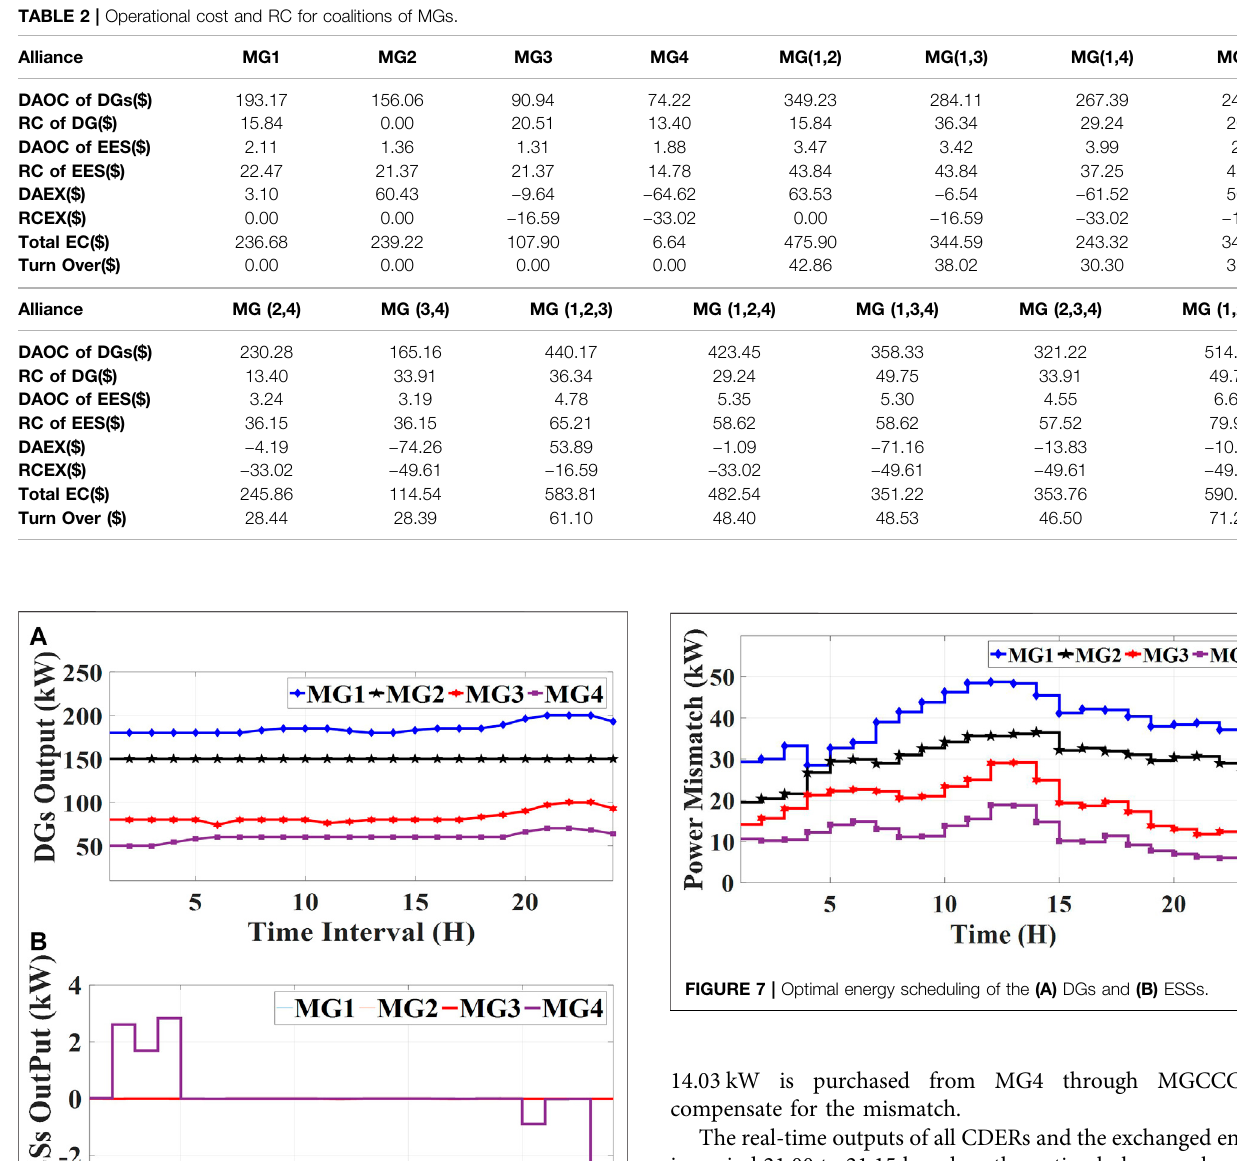
14.03 kW is purchased from MG4 through MGCCC to compensate for the mismatch. The real-time outputs of all CDERs and the exchanged energy in period 21:00 to 21:15 based on the optimal plan are shown in subsection Figure 9 . The output of the WTs in MG1 increases from 42.1 kW (planned value) to 50.52 kW (real-time value), the load increases from 302.70 kW to 332.97 kW, and the PV output decreases from 1.44 kW to 1.296 kW. Since the DG was scheduled to operate on a full load, it cannot participate in reducing the mismatch. Therefore MG1 purchases 8.49 kW from MG3 and 25.14 kW from MG4 through MGCCC to compensate for the mismatch. As shown in Figure 10 , the frequency of the MGs for periods 5:00 – 5:15, 12:00 – 12:15, and 21:00 – 21:15 are stabilized from 49.89 Hz , 49.88 Hz, and 49.86 Hz – 50 Hz respectively, after reserve sharing. Figure 11A depicts the energy sharing and Figure 11B depicts the reserve sharing among the MGs. Using the obtained optimal coalitional energy and reserve scheduling solution for MG (1,2,3,4), we obtain the values of the